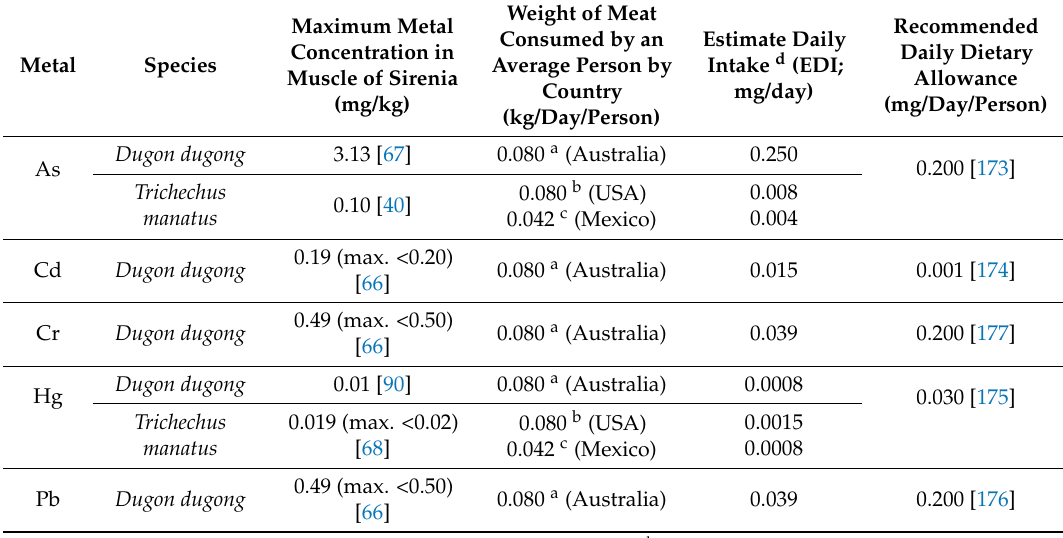
Table 1. Maximum metal concentration (mean or single reported value) in the muscle of Sirenia